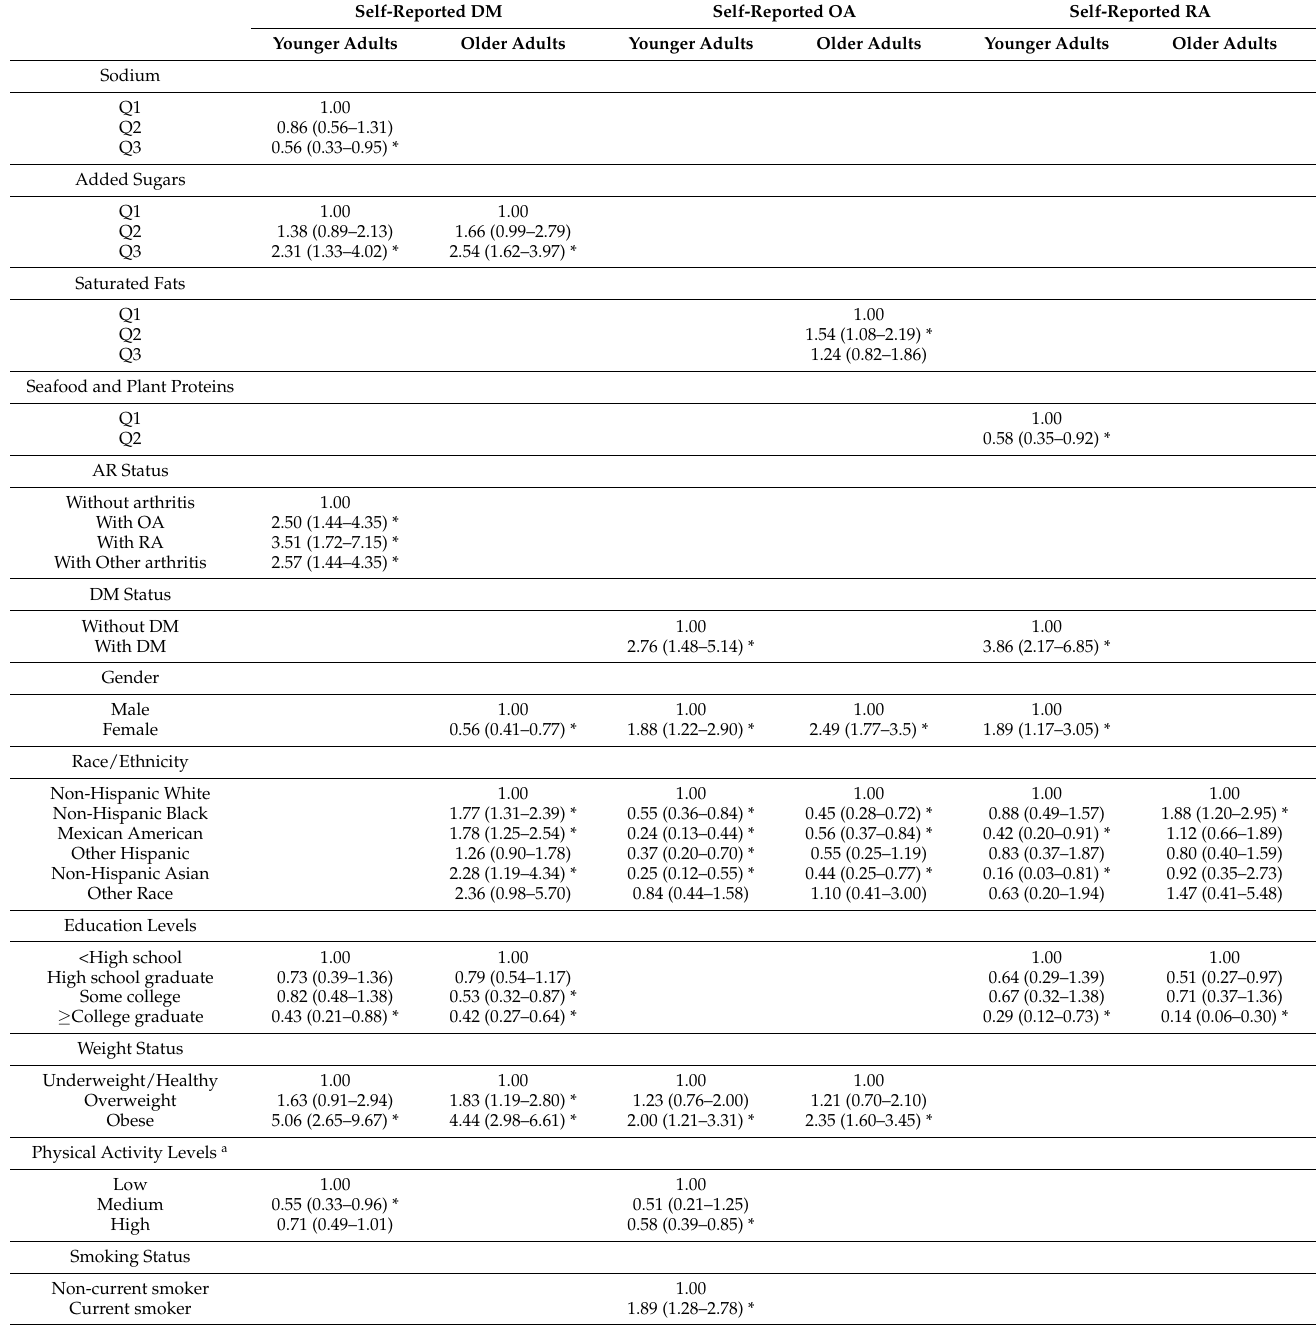
Table 6. Adjusted odds ratios and 99% confidence intervals for self-reported diabetes mellitus, osteoarthritis, and rheumatoid arthritis among younger and older US adults from the final Models with the Healthy Eating Index 2015 component scores: NHANES